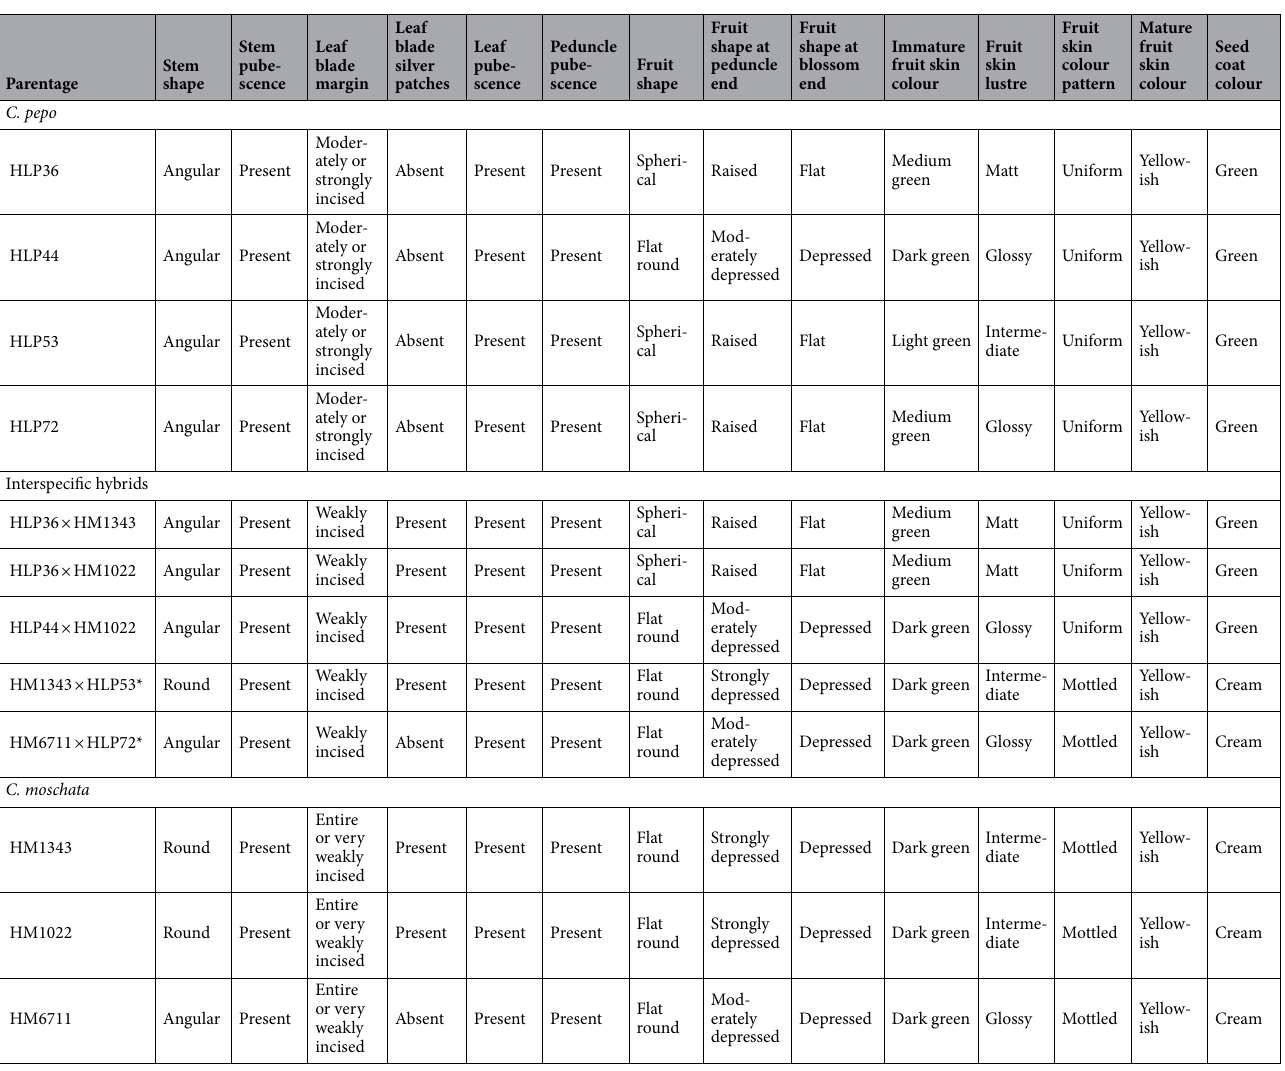
Development and characterization of F populations for hull‑less seed trait. All the F 2 1 seeds obtained from the successful interspecific crosses between C. pepo × C. moschata were sown and then selfed. Approximately 80% of the interspecific F 1 plants set the selfed fruits and each fruit had 40–50 seeds. The F 2 populations of family I, family II and family III were raised from half of the fruits because pumpkin is a wider spaced crop (3 m × 60 cm) which is the major constraint in developing large population. However, all the seeds of each selected fruit were grown so that segregation ratios do not get affected. For the interspecific F 1 hybrids of family IV and family V developed through ovule culture, all the F 2 seeds were grown, selfed and then pheno- typed for seed type. The seeds collected from interspecific F 2 plants from all cross-combinations (Family I to Family V) were phe- notyped (Table 6, Fig. 3). The hulled nature of seeds in F 1 generation indicated recessive nature of hull-less trait. The F 2 populations of HLP36 × HM1343 (Family I), HLP36 × HM1022 (Family II), HLP44 × HM1022 (Family III) and HM6711 × HLP72 (Family V) were segregated into 189, 53, 21, 36 and 26 hulled and 51, 10, 2, 4 and 5 hull-less seeded plants, respectively. Chi-square analysis indicated a mendelian ratio of 3:1 (hulled:hull-less) as best fit in this hypothesis, which suggested that hull-less trait is governed by single gene. However, F 2 population of HM1343 × HLP53 (Family IV) showed the segregation distortion w.r.t ratio 3:1. Further, a representative of interspecific F 2 population (72 plants) derived from HLP36 × HM1343 cross was genotyped for hull-less seed trait using SSR marker, CMTp182 to assess the marker-trait association. However, only 58 (80.55%) plants displayed the accurate seed phenotype as predicted by the genotype (Supplementary Fig. 4a,b).